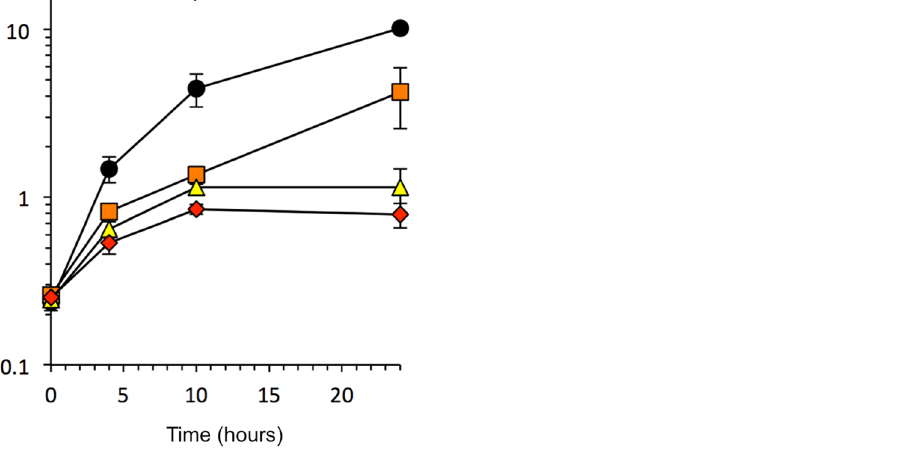
(Fig. 5A). Northern analyses indicated that B. infantis ahpC was strongly upregulated within 10 minutes after the start of aeration (Fig. 5B). These results indicate that B. infantis express the genes for ROS production and for ROS detoxification in response to O 2 stress.